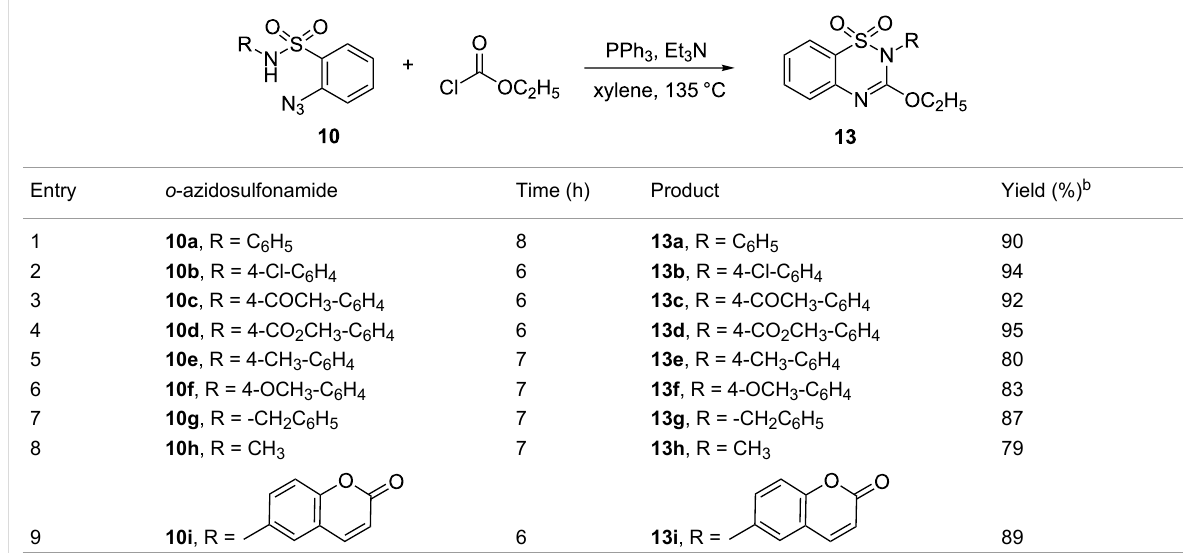
cient R-substituents at the 2-position proceeded